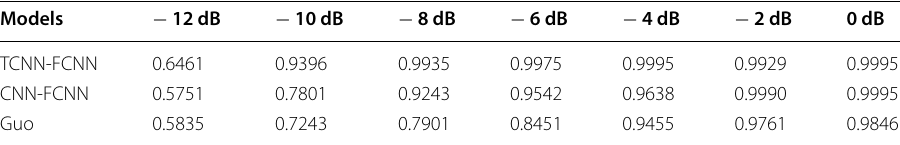
Table 2 Macro F 1